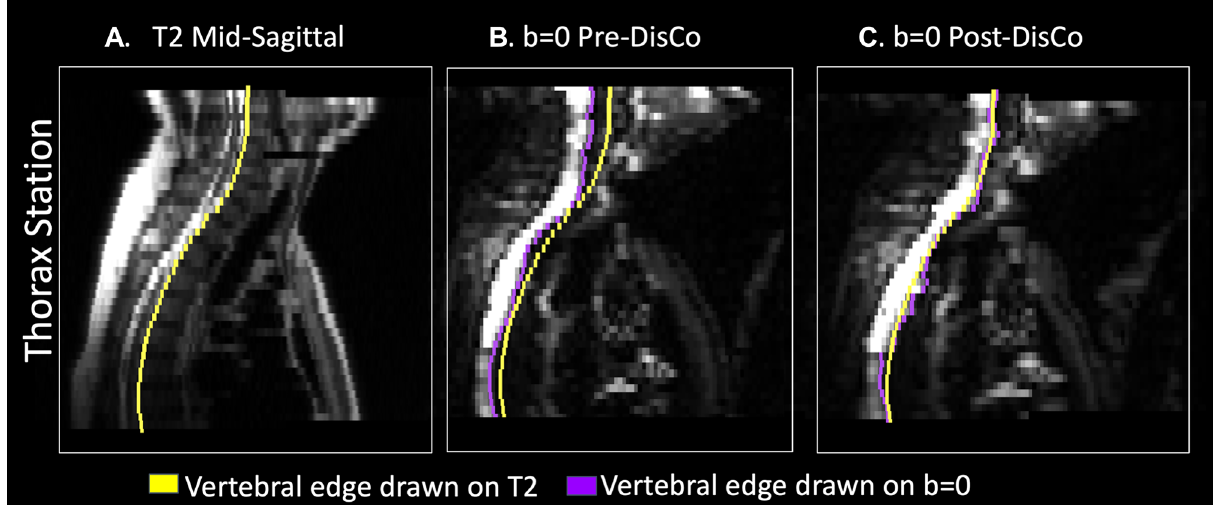
Figure 1. Example of tracing of posterior border of vertebrae for error change analysis. ( A ) Mid-sagittal slice of T2-weighted MRI from the Thorax Station for a single subject. The yellow represents the annotation of the posterior edge of the vertebral column on the T2. ( B ) Mid-sagittal slice of the DWI b = 0 s/mm 2 prior to DisCo. The purple in this panel represents the annotation of the posterior edge of the vertebral column on the pre-DisCo DWI b = 0 s/mm 2 . ( C ) Mid-sagittal slice of DWI b = 0 s/mm 2 after DisCo. The purple in this panel represents the annotation of the posterior edge of the vertebral column on the post-DisCo DWI b = 0 s/mm 2 . The average distance between the yellow and purple tracings (i.e., the error) decreases after application of DisCo. DisCo distortion